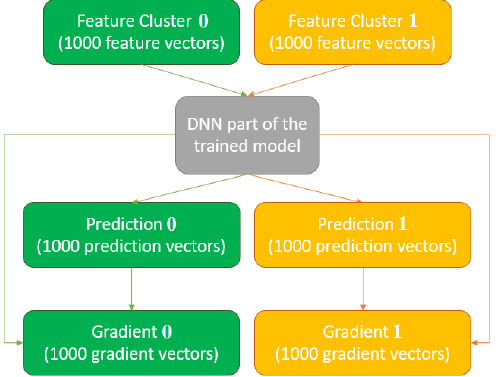
Figure 4. The process to obtain the gradient per cluster.